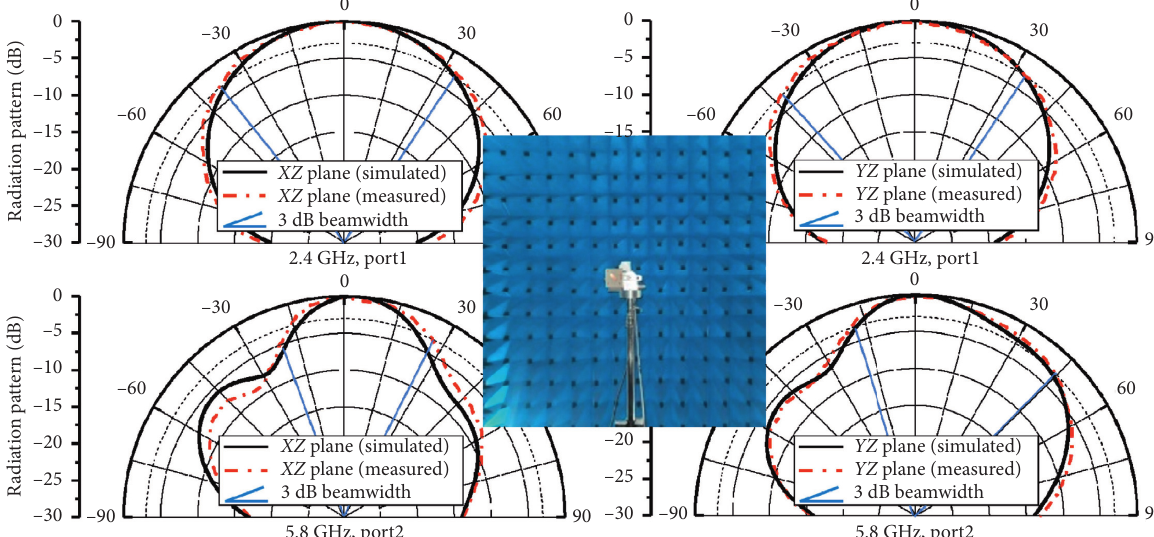
Figure 6: Simulated and measured normalized radiation patterns (RP) at 2.45GHz and 5.8GHz in XZ and YZ planes.